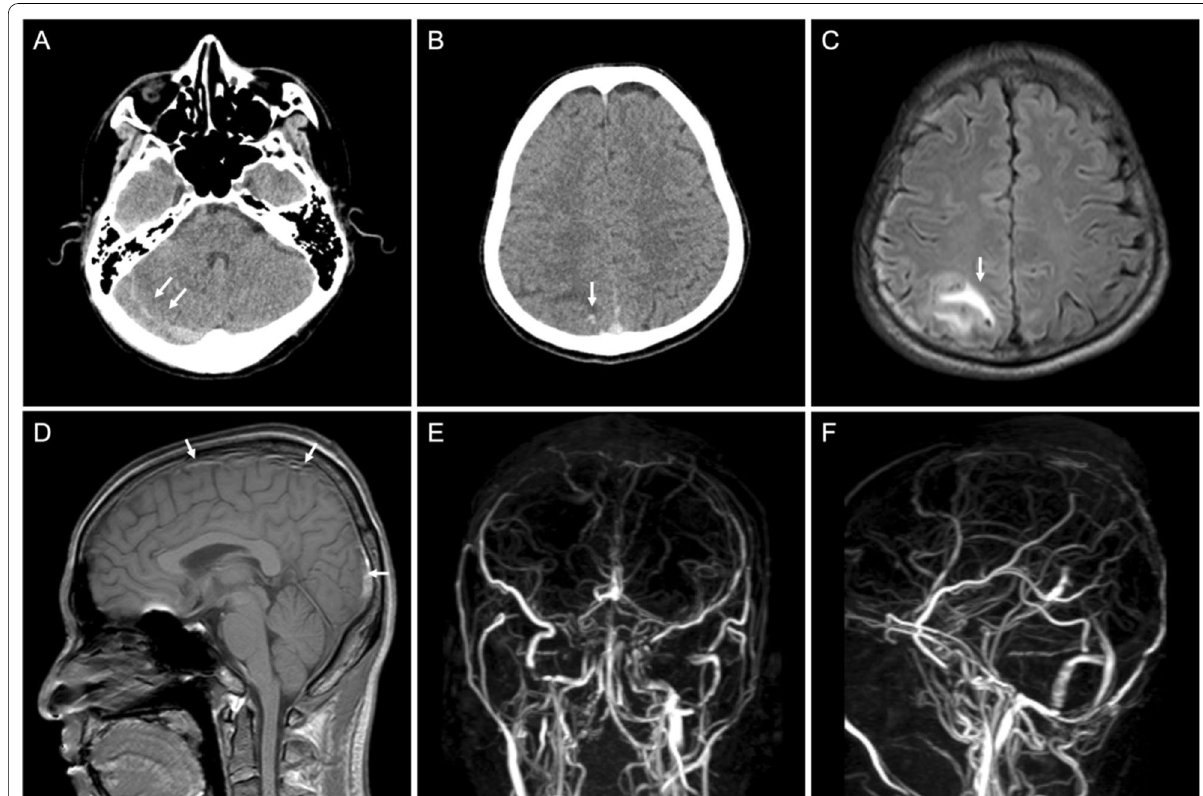
Fig. 1 Non-contrast head CT demonstrating SDH of the posterior fossa with an approximate diameter of 0.6 cm ( A ), and small parasagittal ICH of the right parietal lobe surrounded by perifocal edema ( B ). Head MRI: FLAIR sequence reveals perifocal edema surrounding the site of hemorrhage ( C ), and T1-weighted MRI reveals thrombosis of the superior sagittal sinus ( D ). Head MRV (phase-contrast technique) demonstrates thrombosis of the superior sagittal sinus, right transverse sinus, right sigmoid sinus, and right sinus of trolard ( E , F